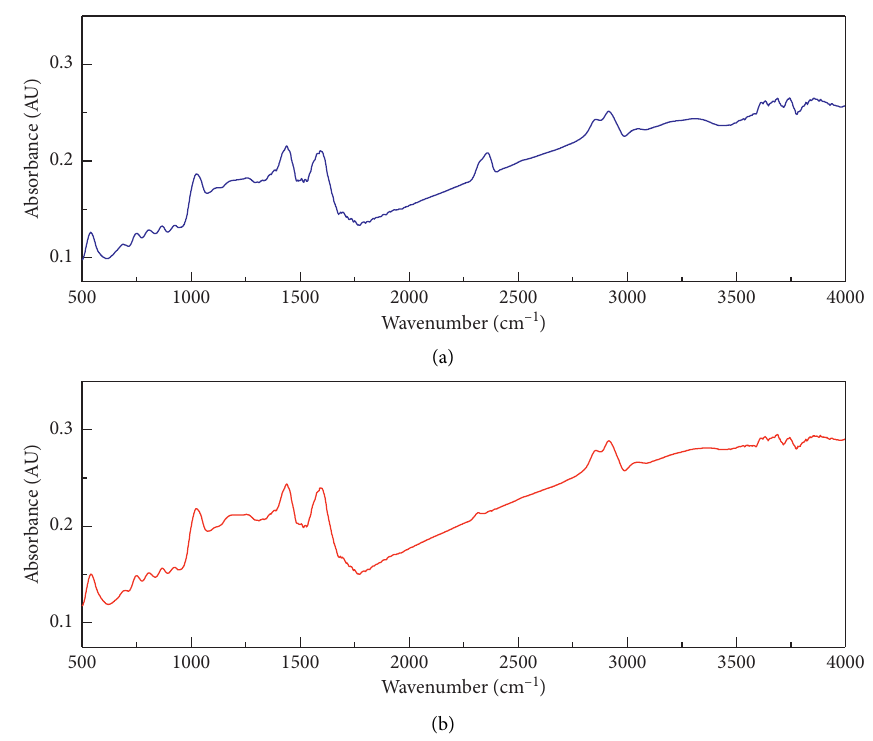
Figure 8: Infrared spectra of the coal samples before (a) and after (b) the action of static blasting